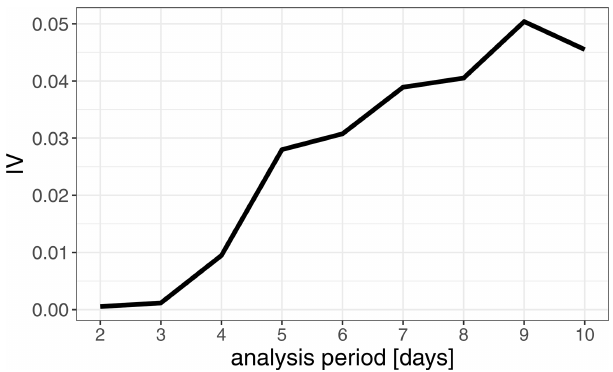
Figure 4. Dependence of the IV for freeze–thaw cycles on the pe- riod used for the